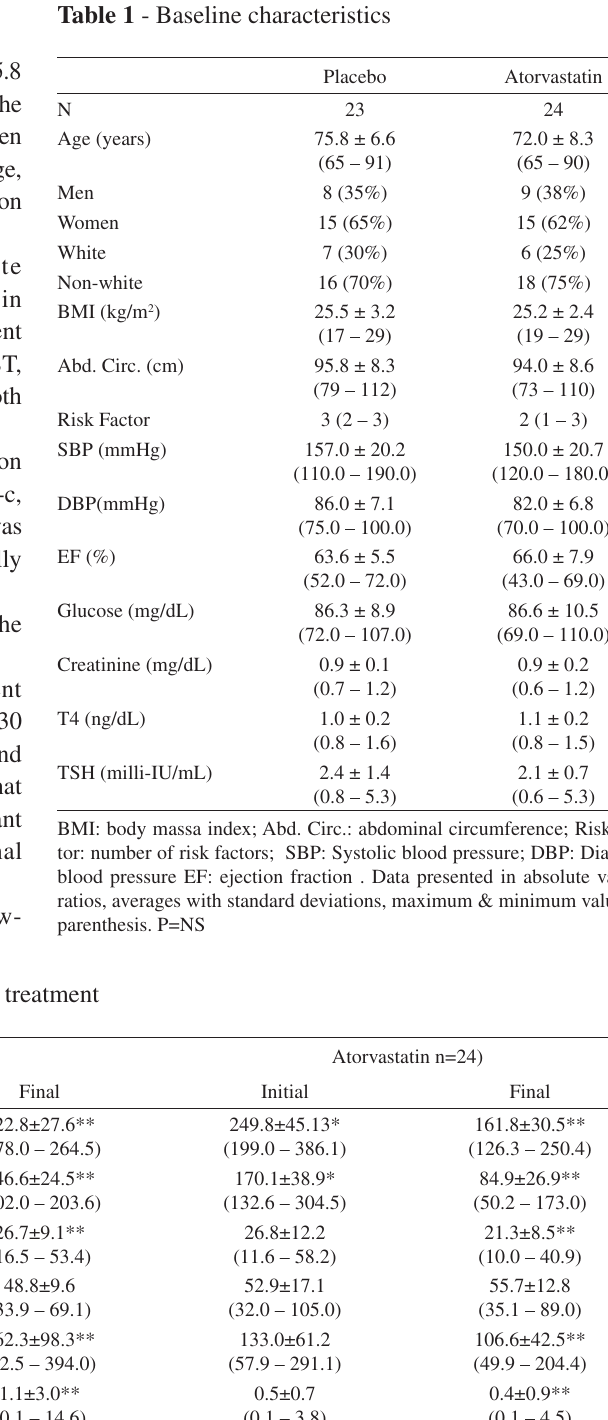
Table 1 - Baseline characteristics